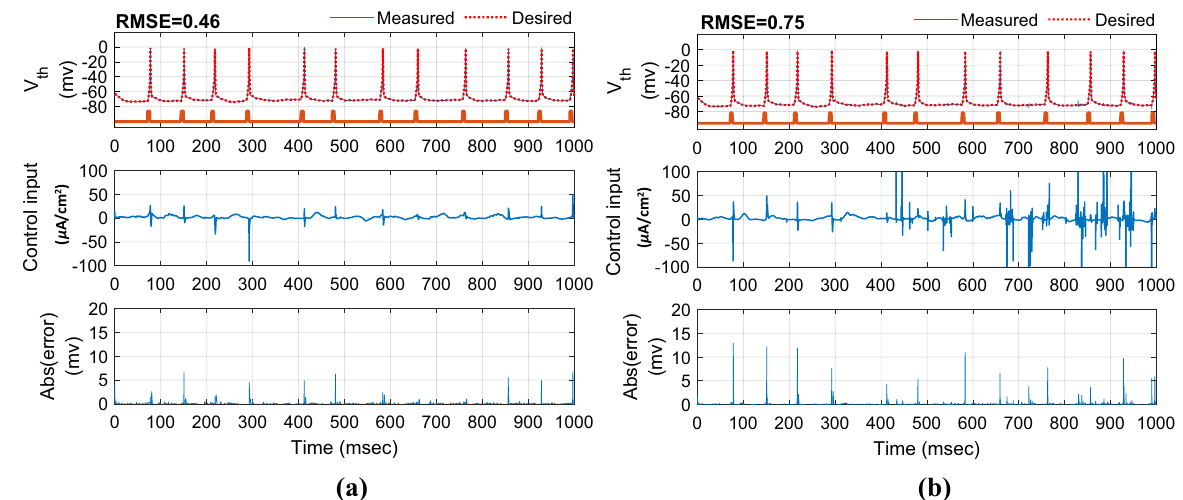
Figure 6. Typical results of the closed-loop control for neuron 1 under 50% time-varying system parameters using ( a ) AFTSMC ( b ) AFSMC.